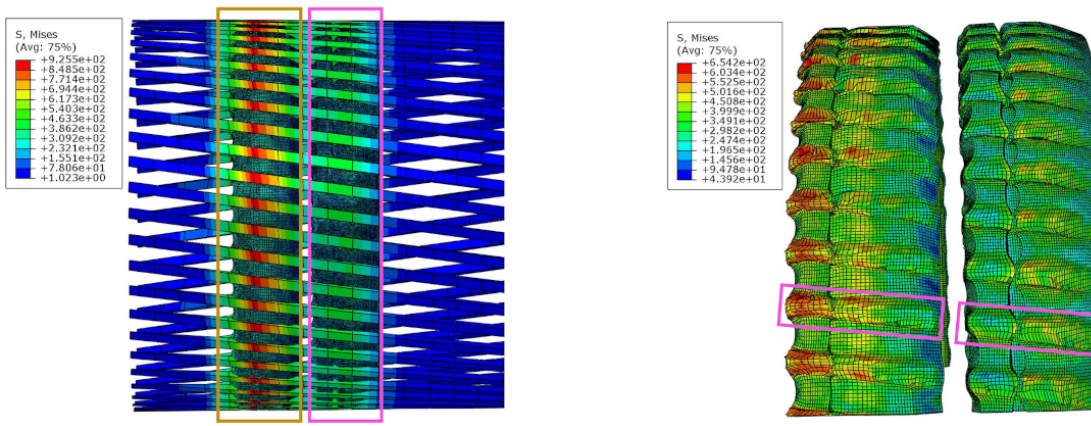
Figure 15. Appearance and stress distribution of the rotating bands and riflings in the third